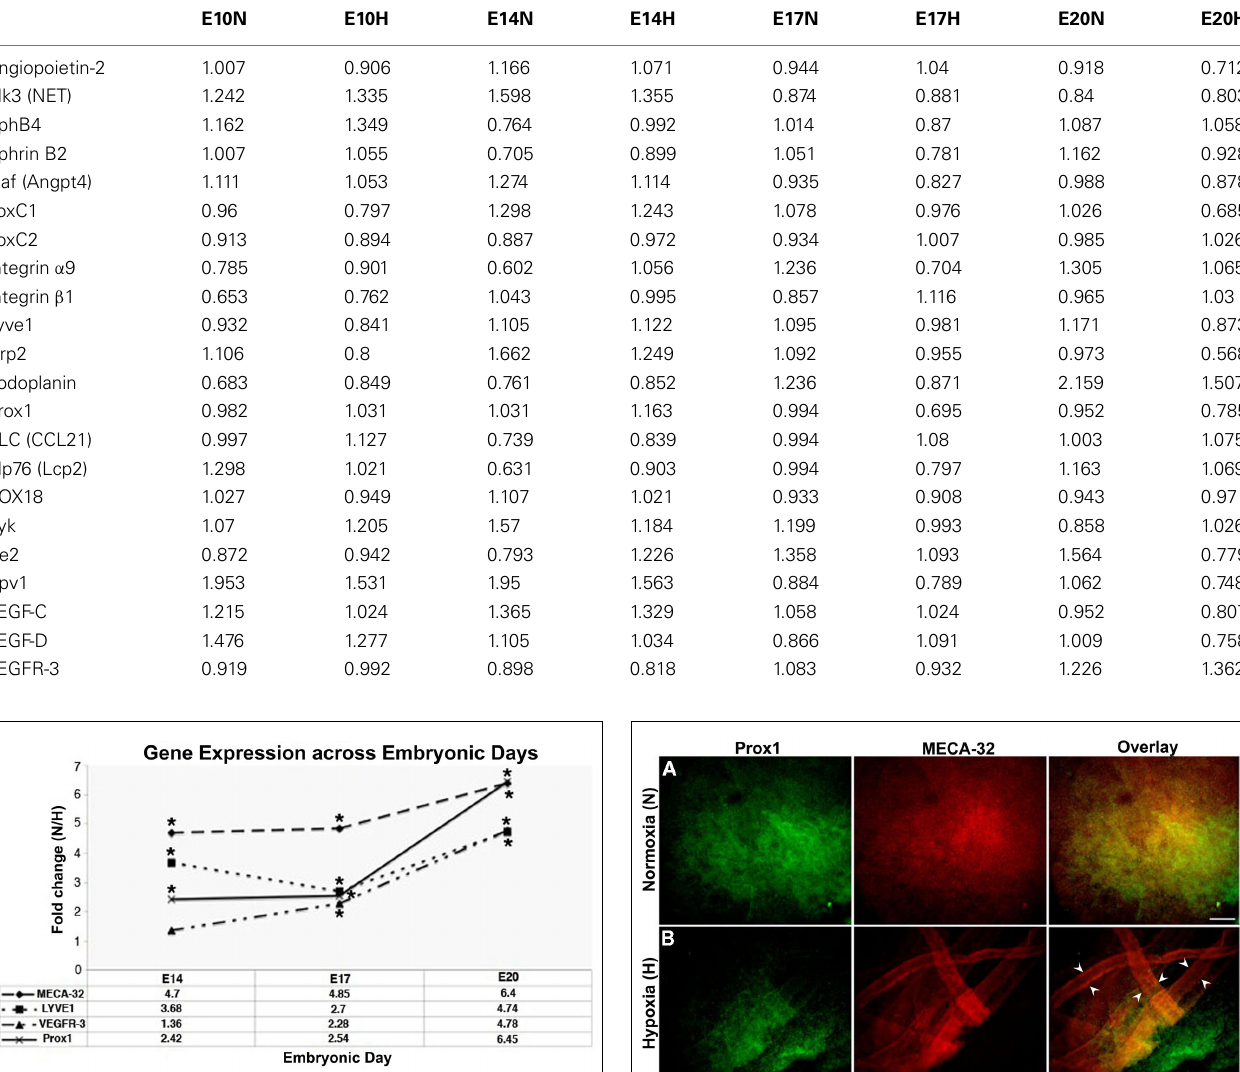
Table 3 |The raw normalized microarray data for selected lymphatic markers at different ages (E10–E20) and oxygen treatments are given.